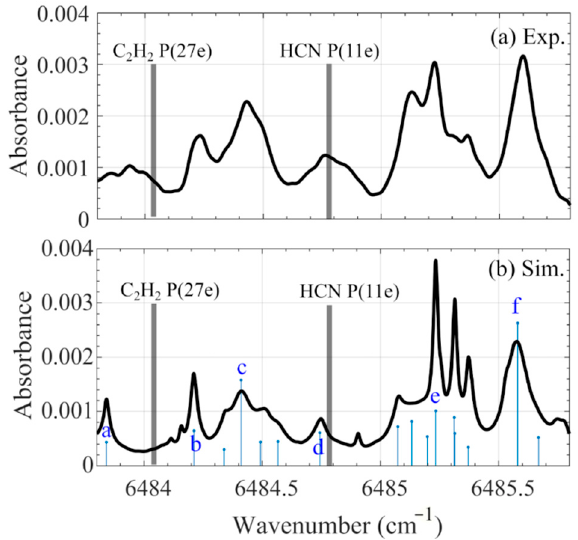
Figure 4. Absorbance spectra of H 2 O measured in the hot flue gas ( T = 1260 K) provided by flame F5 ( a ), and the calculated one of 8% H 2 O at 1260 K using HITEMP2010 ( b ). The chosen lines for HCN and C 2 H 2 are marked with vertical bars. Table 2. Spectra data of the six typical H 2 O transitions indicated in Figure 4b obtained from HITEMP2010. Transition wavenumber ( v ), line intensity ( S ) at 1260 K, lower-state energy ( E ), and the vibrational and rotational quantum numbers for the upper ( ′ ) and lower ( ″ ) states are presented. Tran.